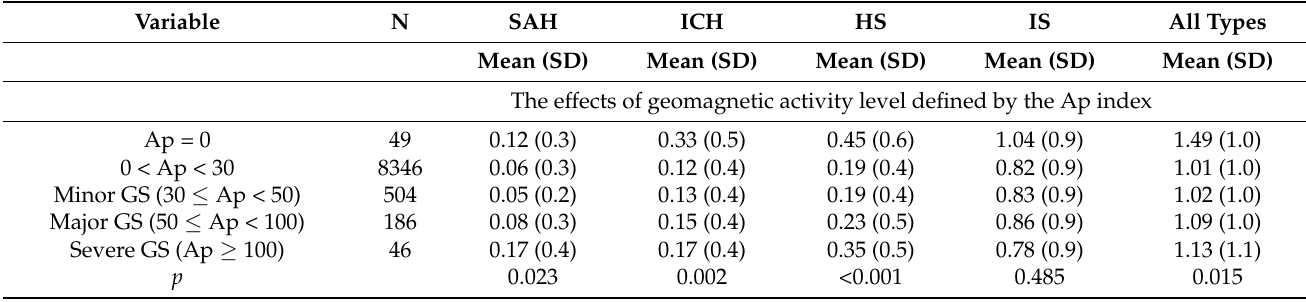
Table 2. The daily mean values of cases of stroke (SD) in groups of different levels of space weather conditions and p -values in the univariate Poisson regression